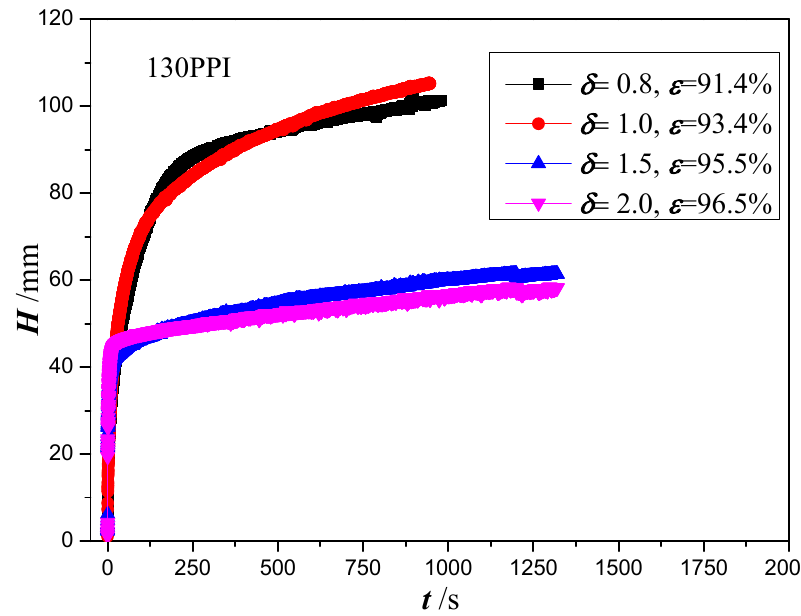
Figure 10. Wicking height versus copper foam with different thicknesses.